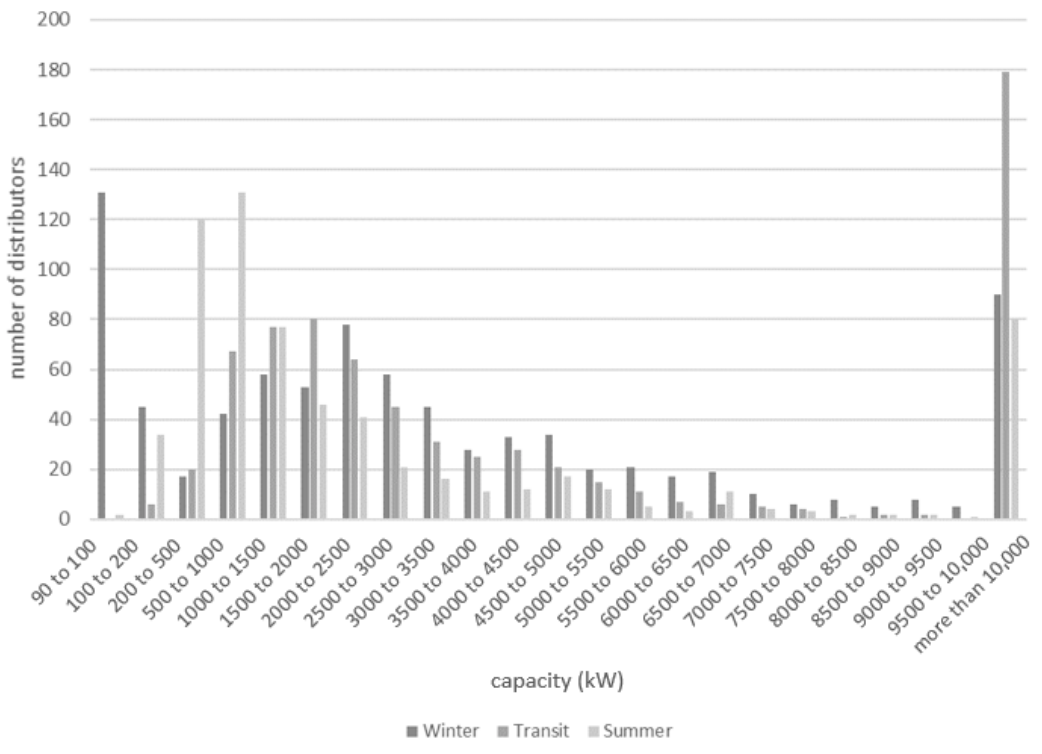
Figure 3. Distribution of distributors by sizes for 2020 in the winter, transit, and summer periods.